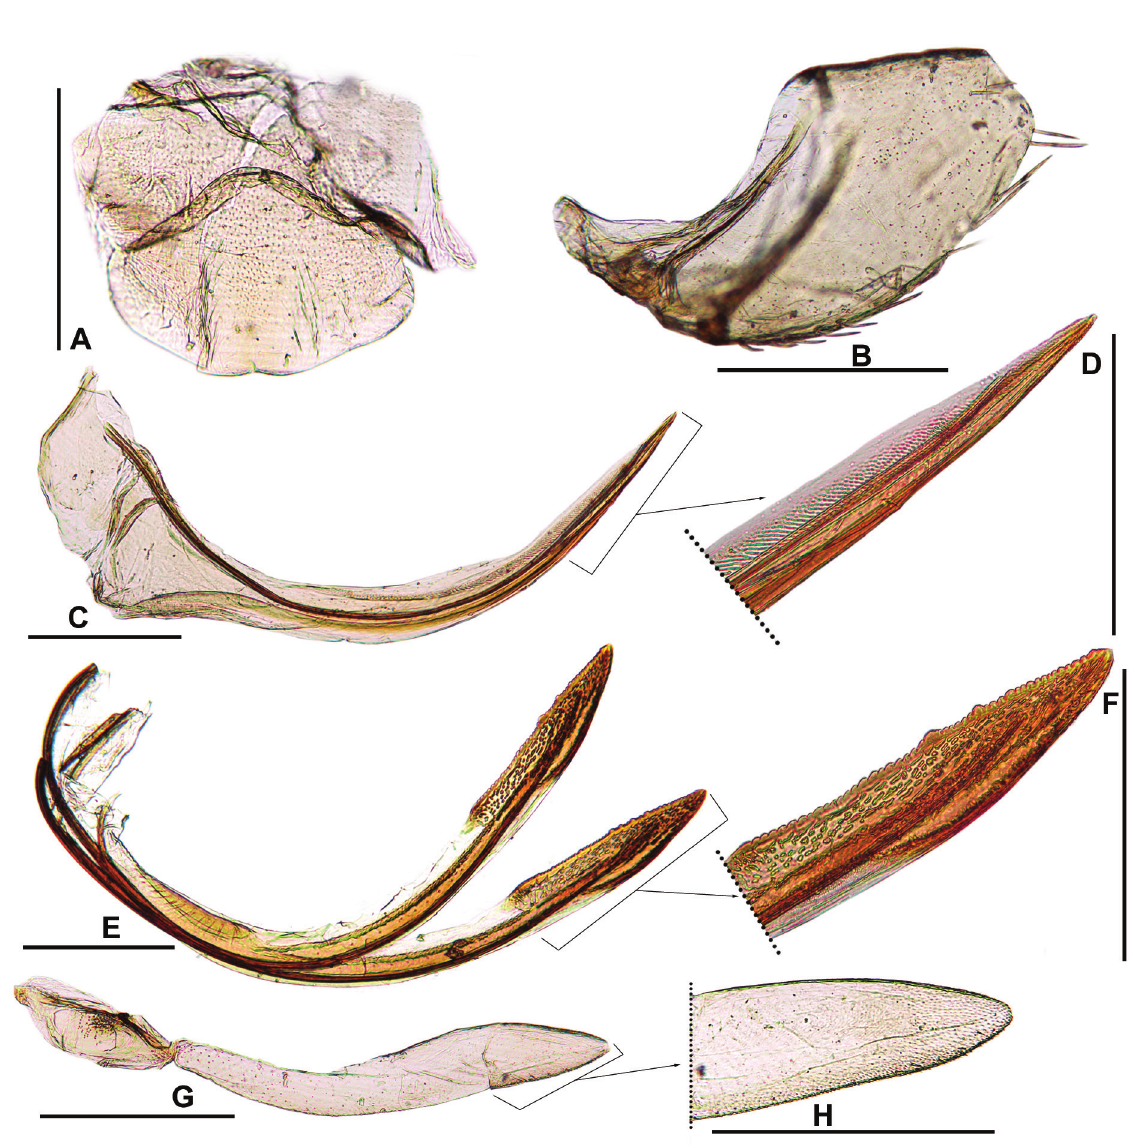
Fig. 11. Takiyaella sexguttata (Chiamolera & Cavichioli, 2003) gen. et comb. nov., ♀, paratype (DZUP-492337). A . Sternite VII, ventral view. B . Pygofer and anal tube, lateral view. C . First valvula of ovipositor, lateral view. D . Apex of first valvula, lateral view. E . Second valvula of ovipositor, lateral view. F . Apex of second valvula, lateral view. G . Second valvifer and gonoplac, lateral view. H . Apex of gonoplac, lateral view. Scale bars: A–C, E, G = 0.5 mm; D, F, H = 0.3